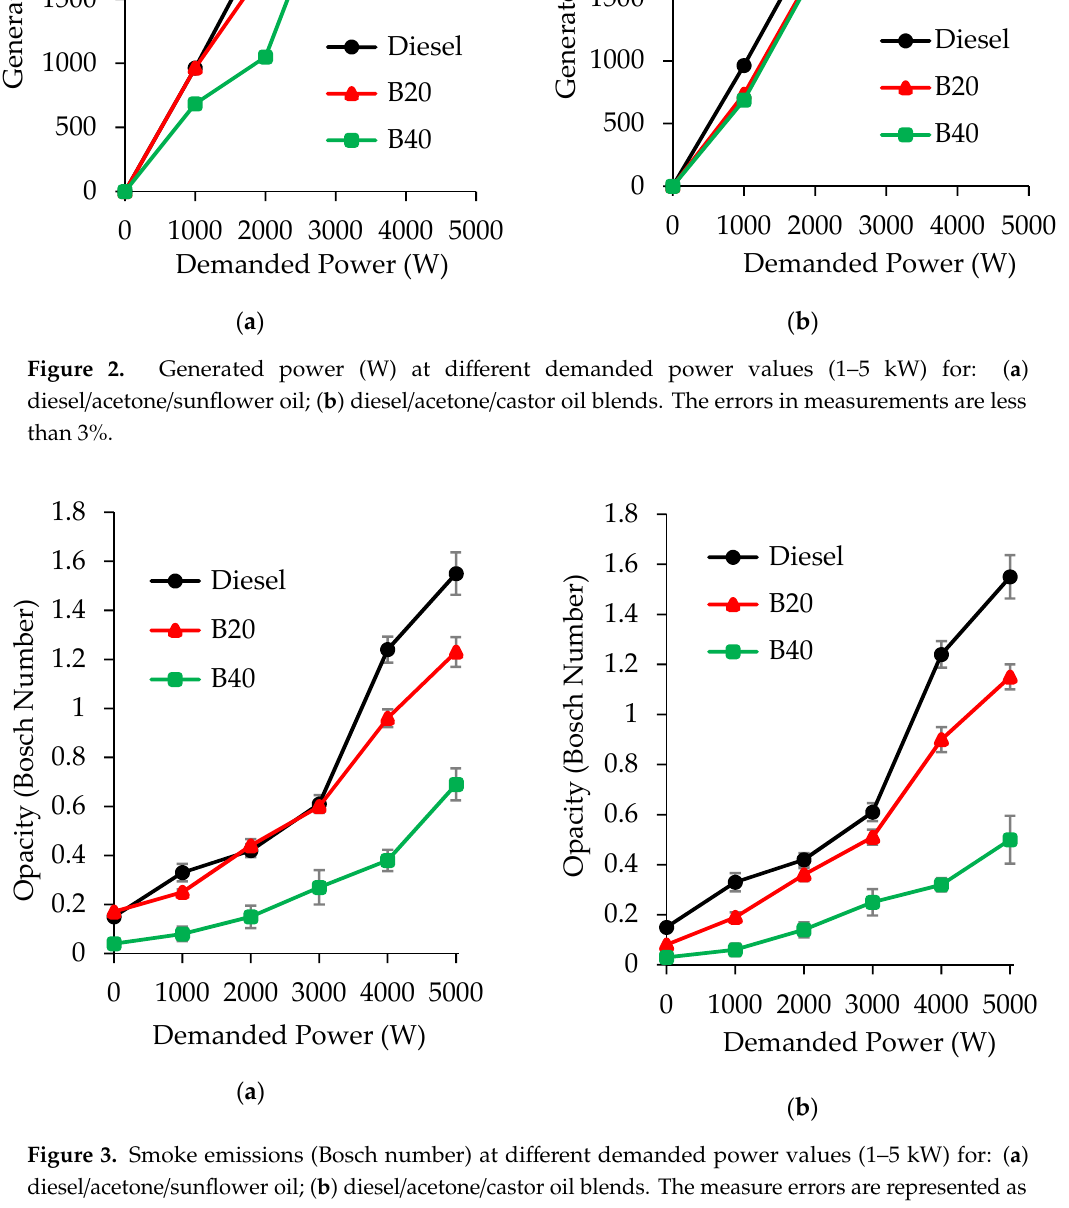
( b ) Figure 4. Fuel consumption values (L/h) at different demanded power values (1, 3, 5 kW) for: ( a ) diesel/acetone/sunflower oil; ( b ) diesel/acetone/castor oil blends. The measure errors are represented as standard deviation using error bars. According to the results obtained, the presence of acetone and oil in blends usually generates greater consumption of fuel than conventional diesel. The cause of this increment in volume of fuel